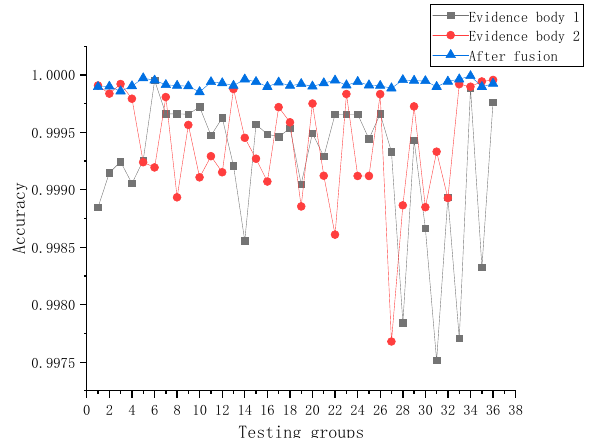
Figure 9. Diagnostic results before and after fusion of evidence.